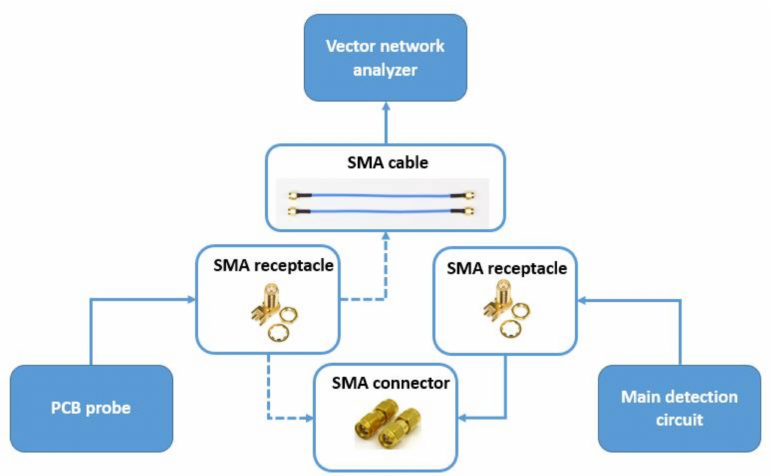
Figure 15. The process of probe